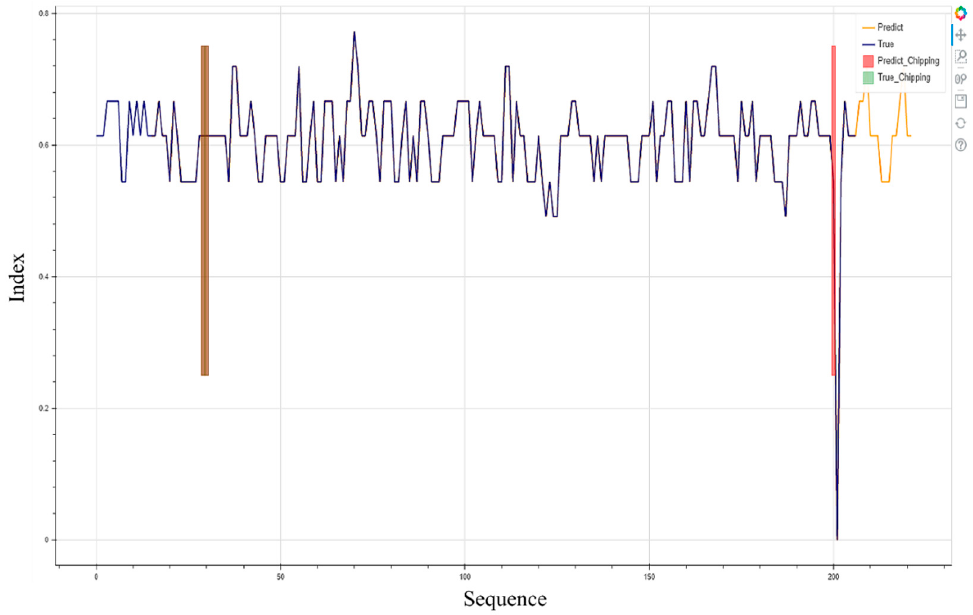
Figure 20. DD-BLSTM prediction of index changes and chipping discovery where the brown rectangle represents the occurrence of predicted chipping and true chipping simultaneously.